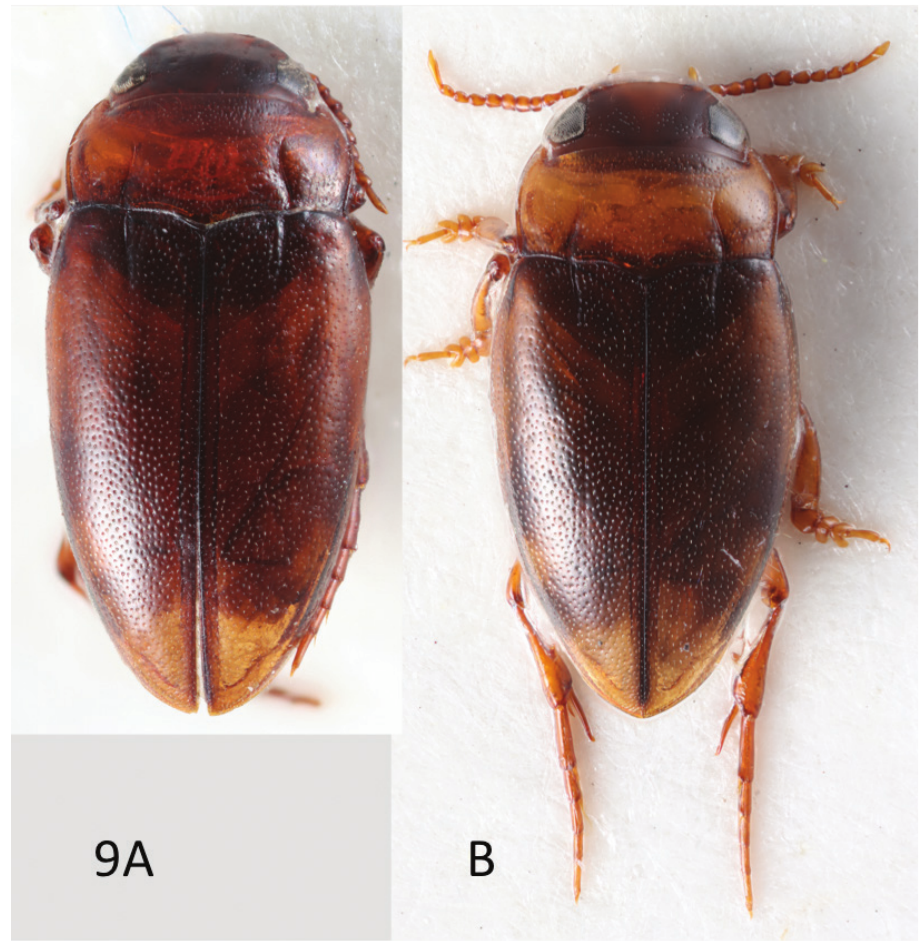
Figure 9. Limbodessus curviplicatus : male paratype of Bidessus curviplicatus Zimmermann, 1927 from Samoa ( A ) and male specimen from Fiji ( B